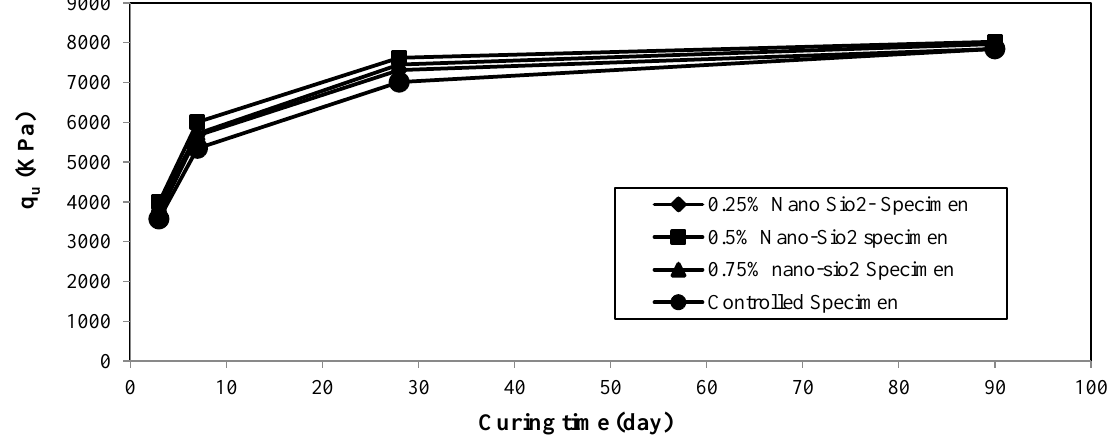
Fig. 11. Strength gain of the mixtures containing different percentages of nanosilica 200